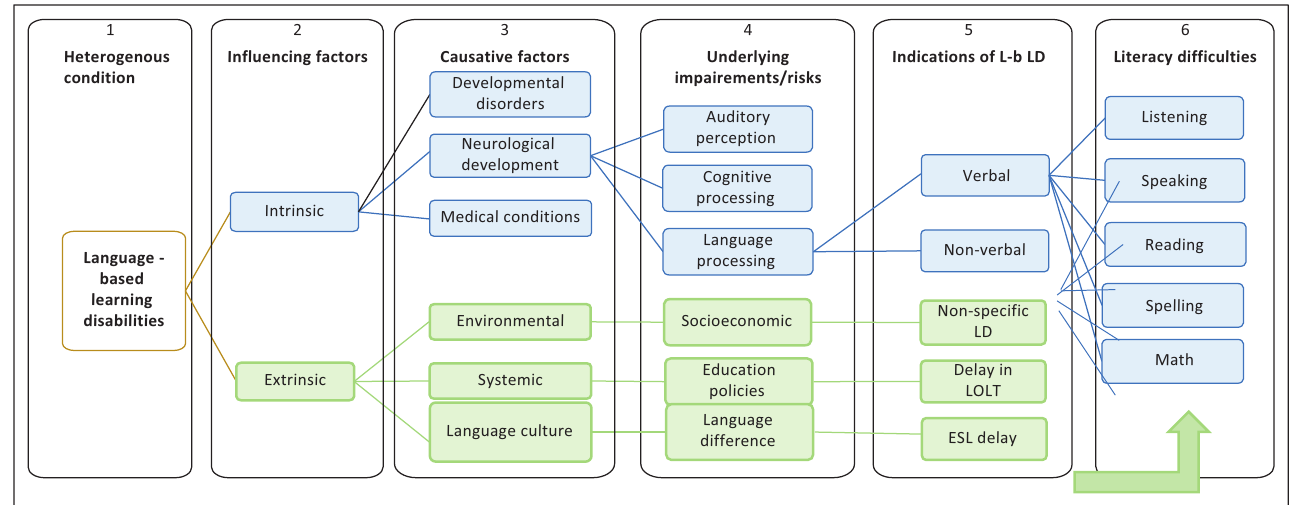
FIGURE 1: Model describing language-based learning disability for South African